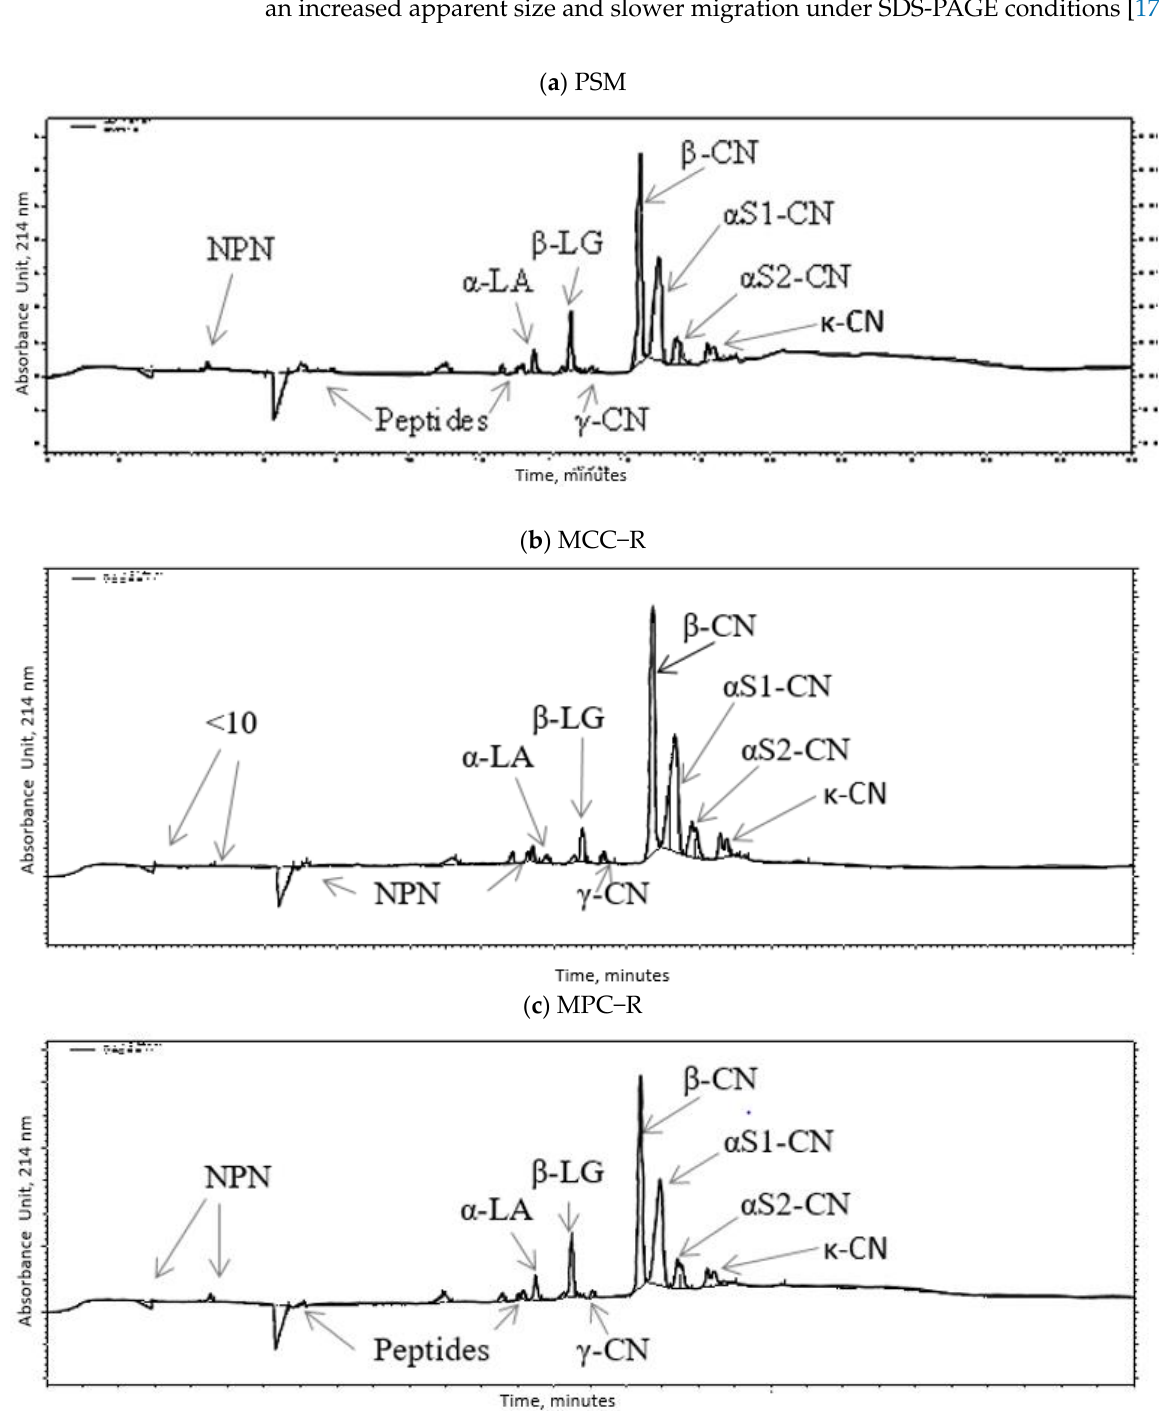
Figure 4. Capillary gel electrophoreogram of ( a ) PSM = pasteurized skim milk; ( b ) MCC-R = micellar casein concentrate retentate; ( c ) MPC-R = milk protein concentrate retentate; NPN = non protein nitrogen.